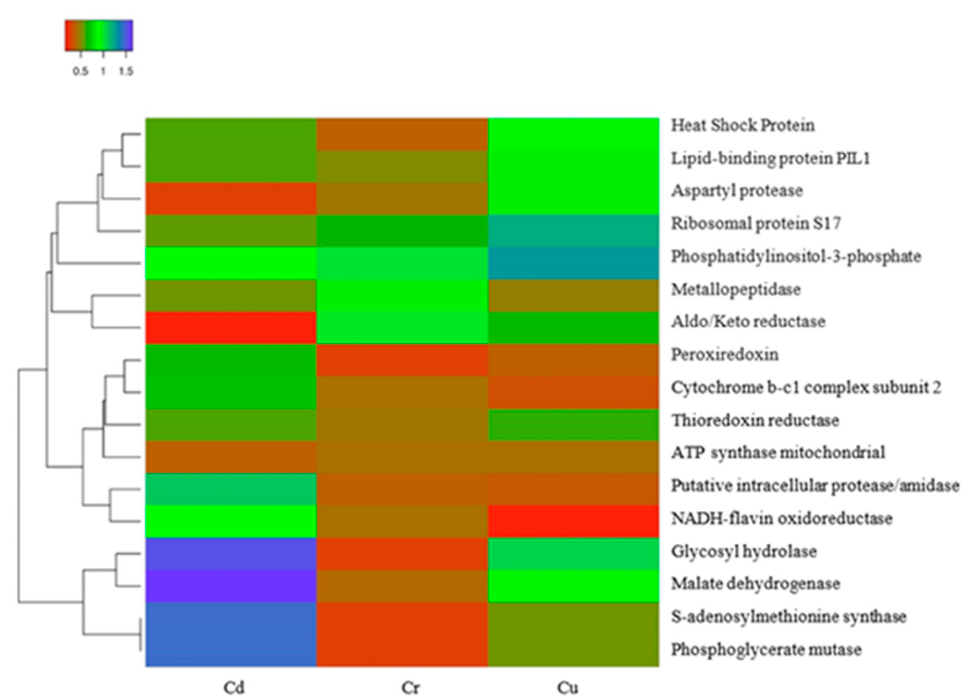
Microorganisms 2022 , 10 , x FOR PEER REVIEW 15 of 22 Figure 14. ( A ) Interaction statistics points of 17 common proteins ( B ) Image of the networking relation common proteins ( C ) The points score connection (node) of the networking common proteins showed ( D ) upregulated proteins, related to carbohydrate metabolism and antioxidant activity.